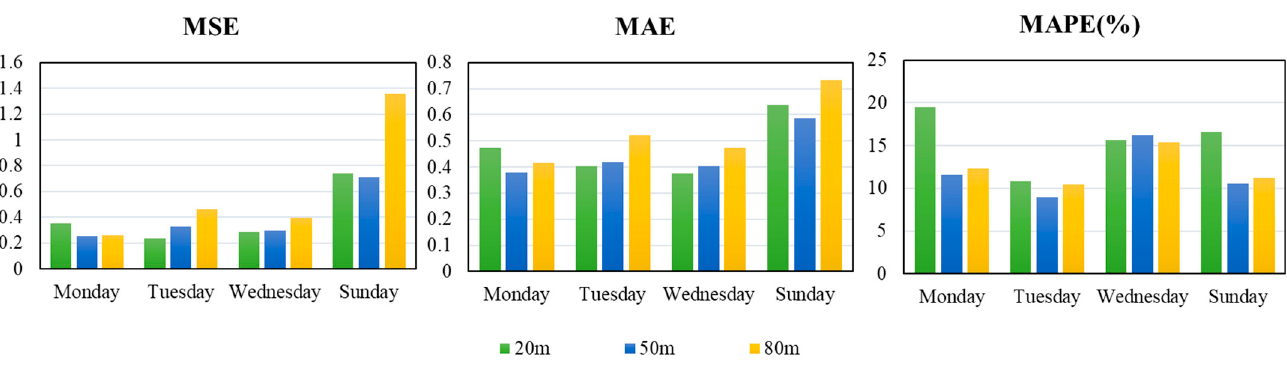
Table 4. The three evaluation indices of the LSTM model.